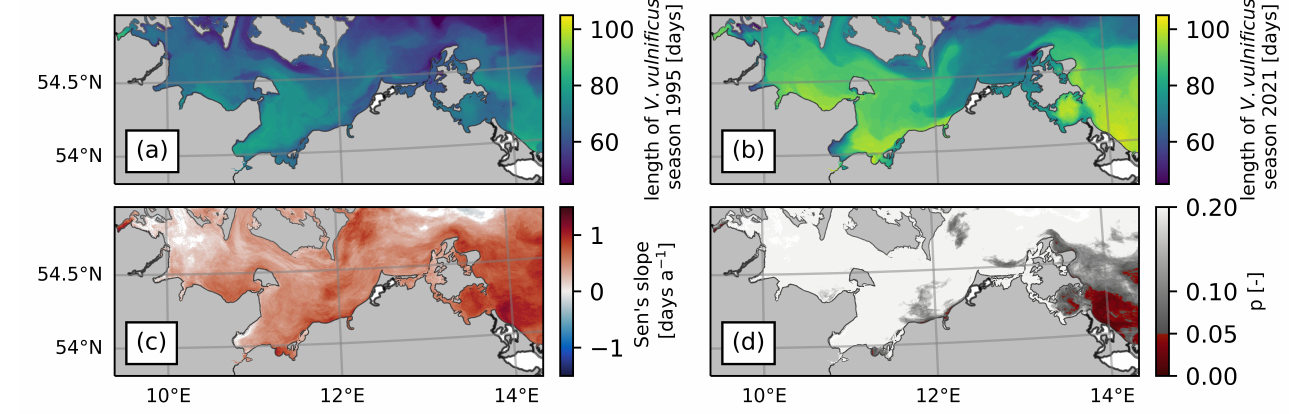
Figure 7. V. vulnificus season length and trends calculated based on SST between 1995 and 2021. ( a ) Season length in 1995. ( b ) Season length in 2021. ( c ) Trend estimated with the Theil–Sen estimator. ( d ) Significance (p) of the trend calculated with the Mann–Kendall